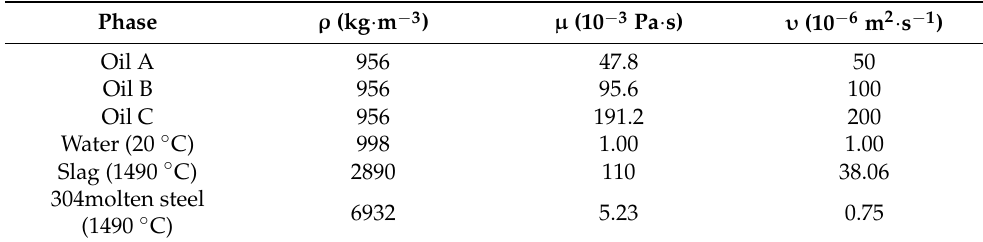
Table 3. Physical properties of each liquid phase.